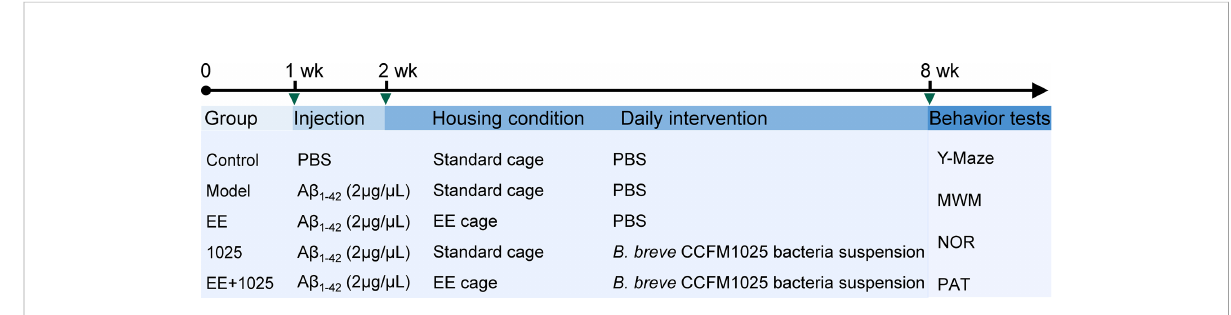
FIGURE 1 Schematic overview of the experimental design and study timeline. Vertical bars represent 1 week. wk, week; EE, Environmental enrichment; A b , Amyloid- b ; PBS, phosphate-buffered saline; MWM, Morris water maze; NOR, novel object recognition; PAT, passive avoidance